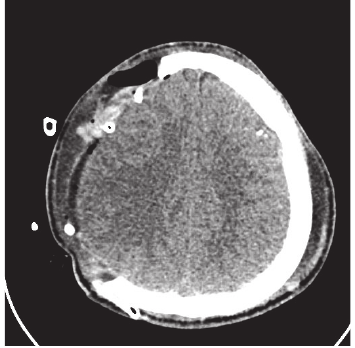
Figure 16. CT scan slice with big fractured part.